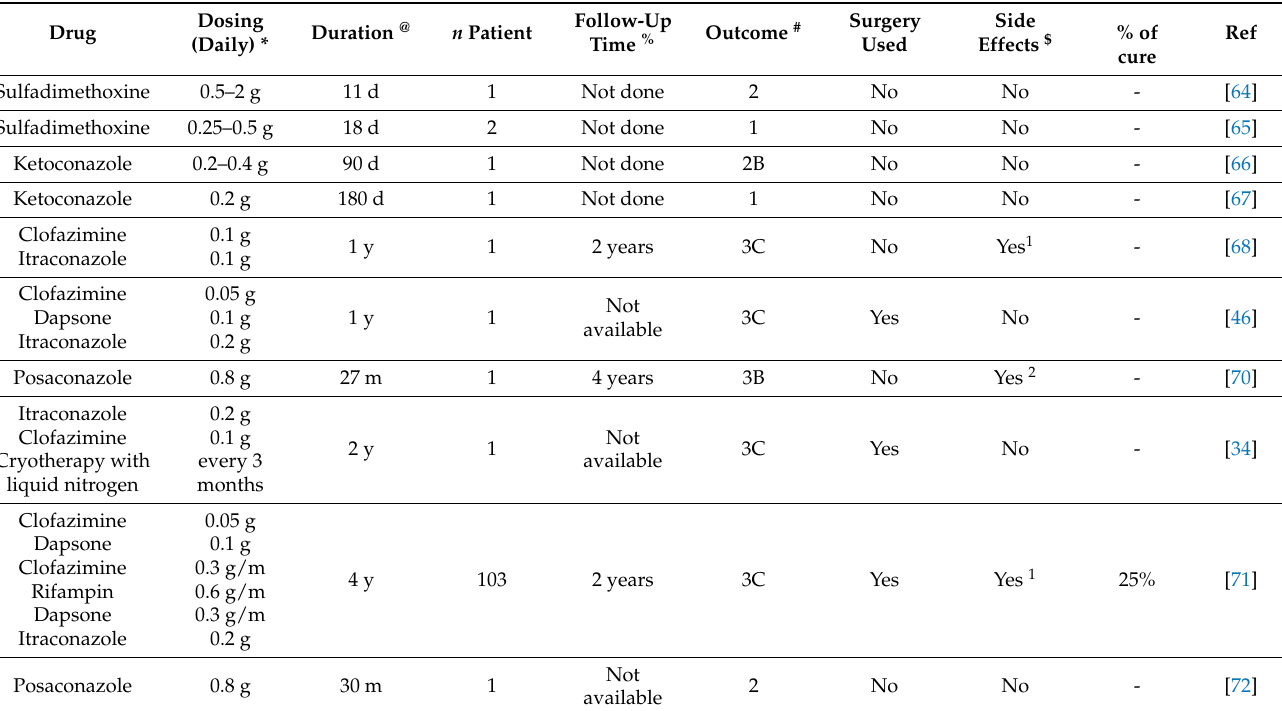
Table 1. Summary of studies on the treatment of lobomycosis, 1960–2021.